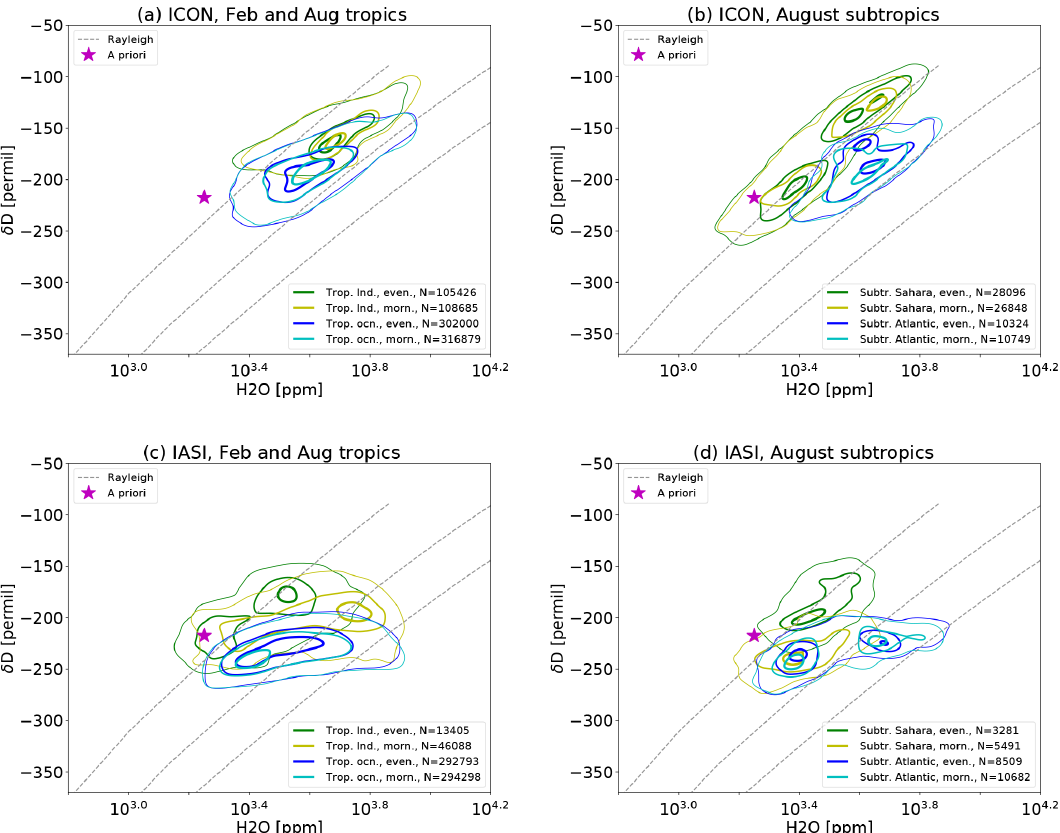
Figure 4. Isolines of the relative normalized frequency distribution for pairs of δ D and H 2 O (see Appendix A for the method) after processing ICON-ART-Iso data with the IASI retrieval simulator of Schneider et al. (2017) (a, b) and IASI data for the same time (c, d) . (a, c) Data corresponding to morning and evening overpasses for the tropics (10 ◦ S < ϕ < 10 ◦ N, all longitudes, summer and winter simulation) over land and over the ocean. (b, d) Morning and evening overpasses for the subtropics (22 . 5 ◦ S < ϕ < 35 ◦ N, summer simulation) over land (Saharan desert region, 10 ◦ W < ϕ < 50 ◦ E) and Atlantic Ocean (50 ◦ W < ϕ < 30 ◦ W). Contour lines are indicated at 0.2, 0.6 and 0.9 of the normalized